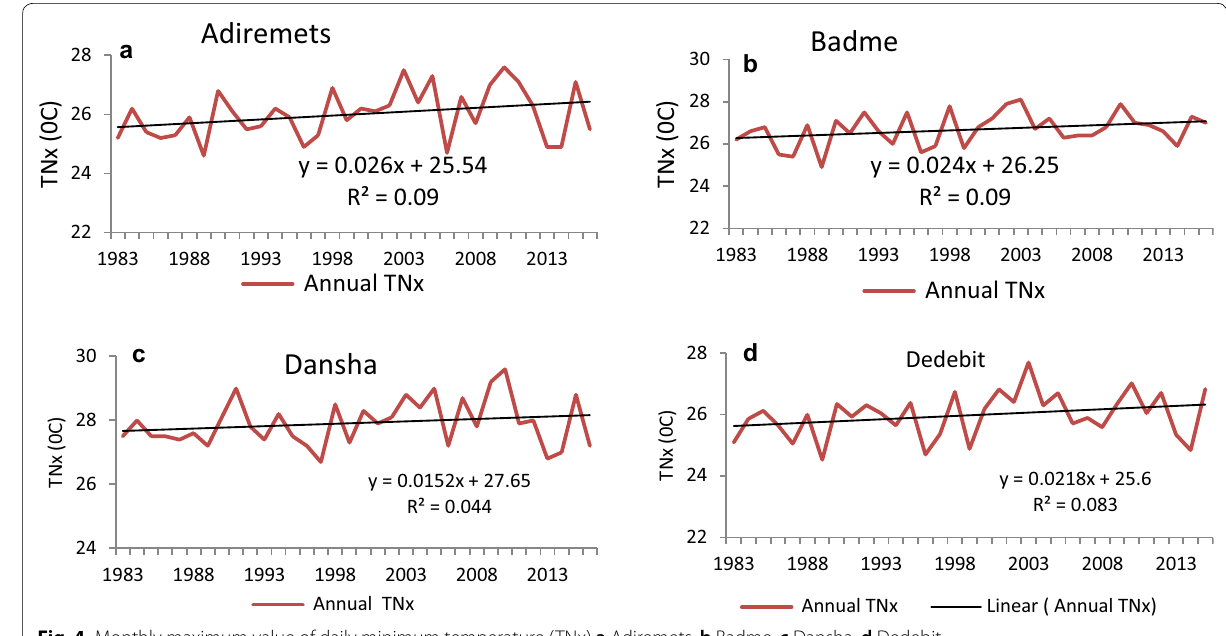
Fig. 4 Monthly maximum value of daily minimum temperature (TNx) a Adiremets, b Badme, c Dansha, d Dedebit